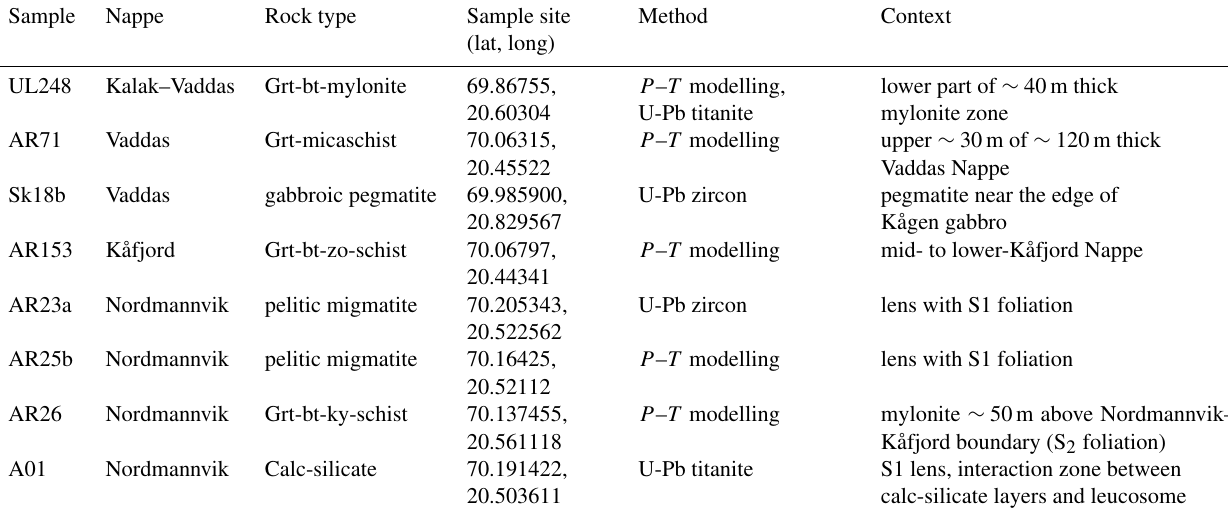
Table 1. List of samples with rock types, sample sites, and methods.